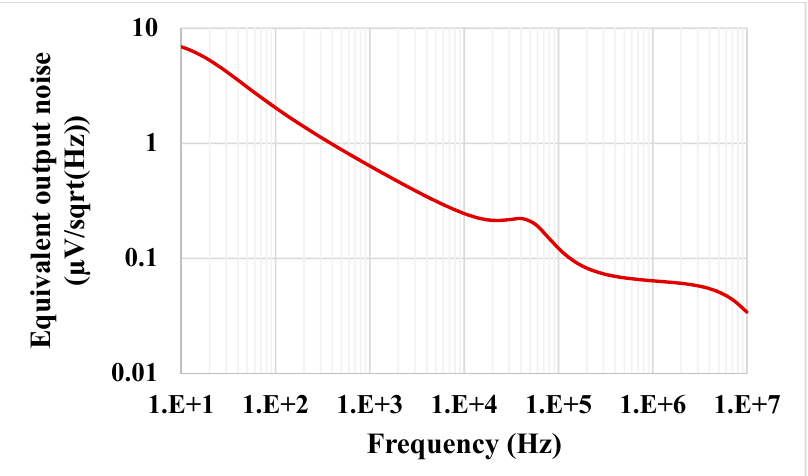
Figure 18. The equivalent output noise of the BP filter.